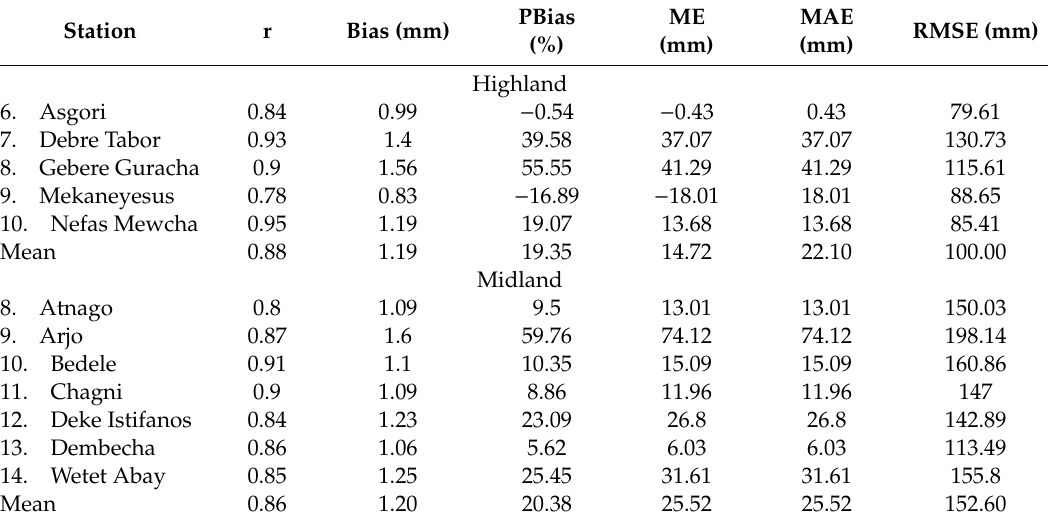
Table 4. Error report for MSWEPv2 for the di ff erent elevation zones of the Upper Blue Nile.